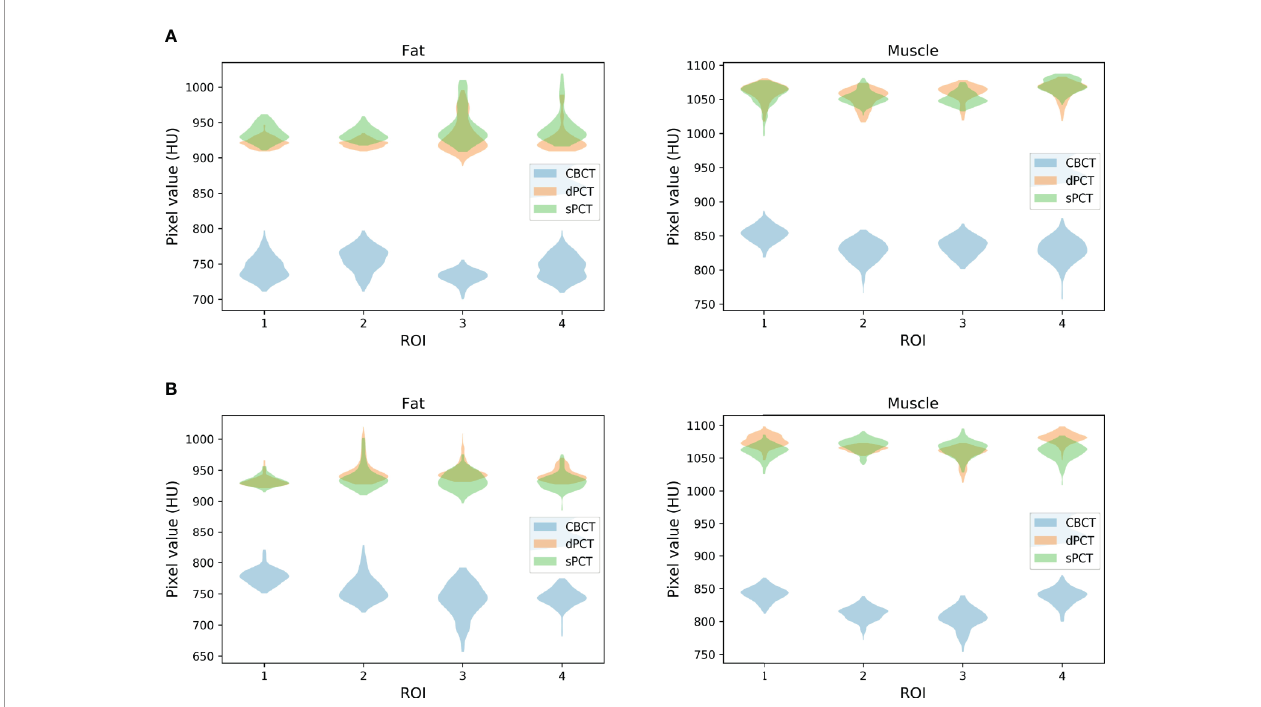
FIGURE 10 | Distribution of CT number of CBCT, sPCT, and dPCT in muscle and fat ROIs. The fi rst and second rows represent two patients (A, B) . The left and right columns represent the distribution of CT number in fat and muscle respectively. The number on the x-axis represents the number of ROIs in the same tissue, and the width represents the ratio of pixels with a speci fi c HU.